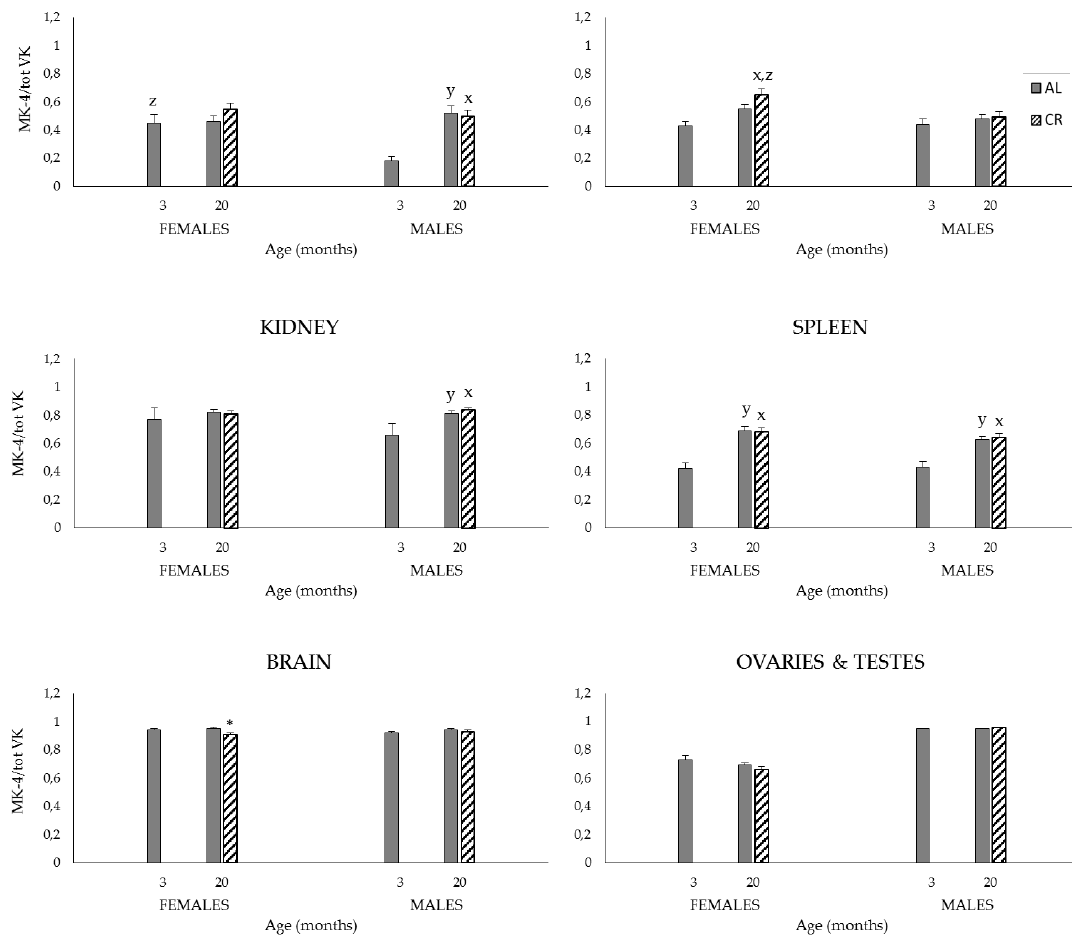
Figure 4. Tissue MK-4/total VK ratios of 3- and 20-month-old M and F Sprague–Dawley rats fed